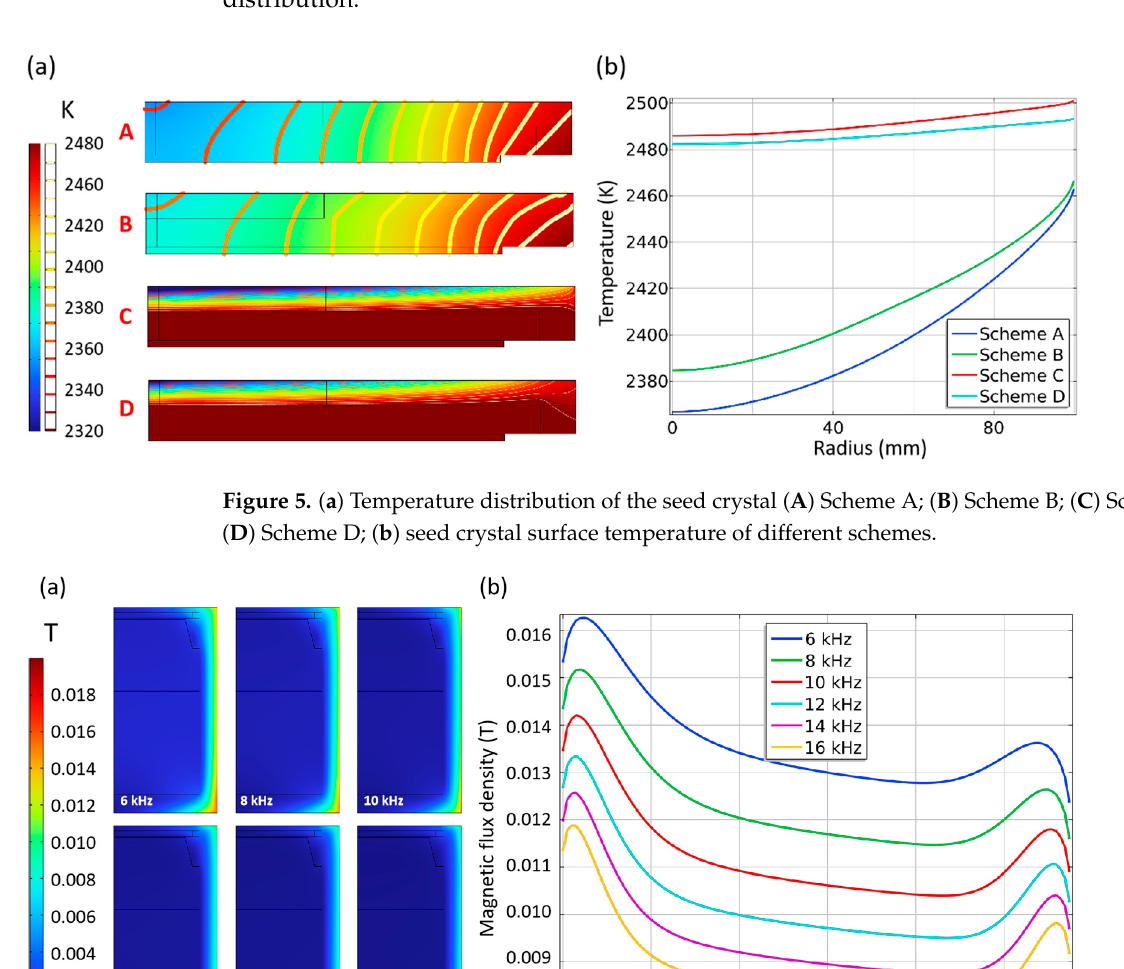
Figure 5. ( a ) Temperature distribution of the seed crystal ( A ) Scheme A; ( B ) Scheme B; ( C ) Scheme C; ( D ) Scheme D; ( b ) seed crystal surface temperature of different schemes.